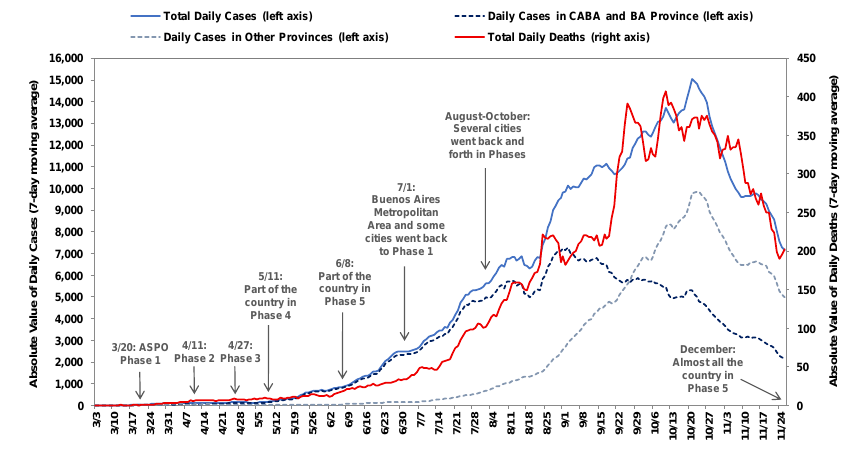
Figure 1: COVID–19 daily cases and deaths in Argentina (7-day moving